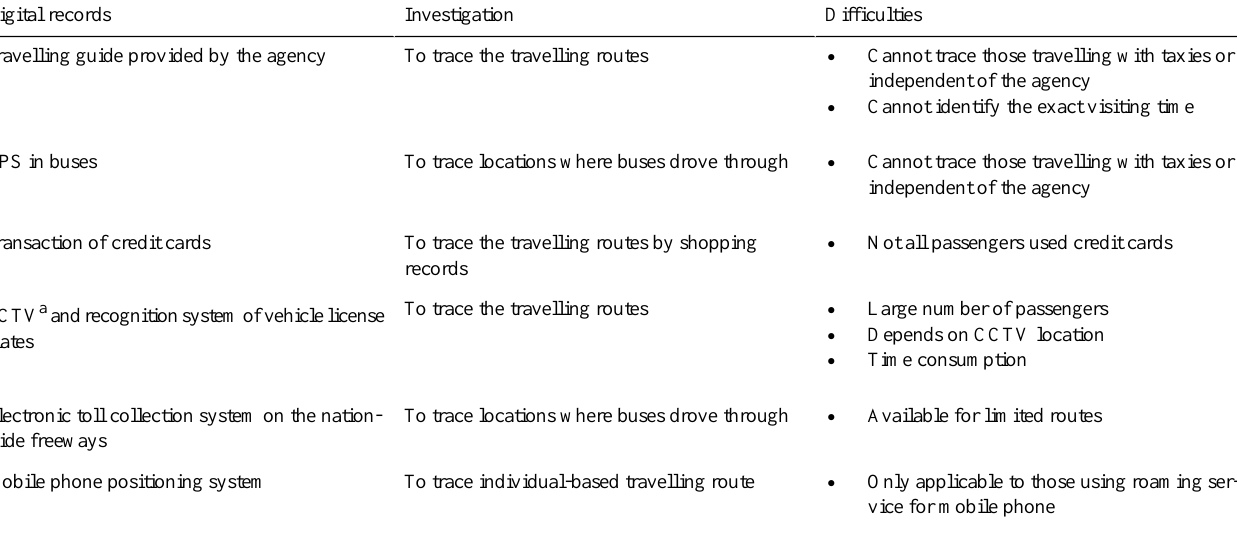
Table 1. Potential means of contact tracing for passengers from the Diamond Princess cruise ship during the 1-day Taiwan tour. DifficultiesInvestigationDigital